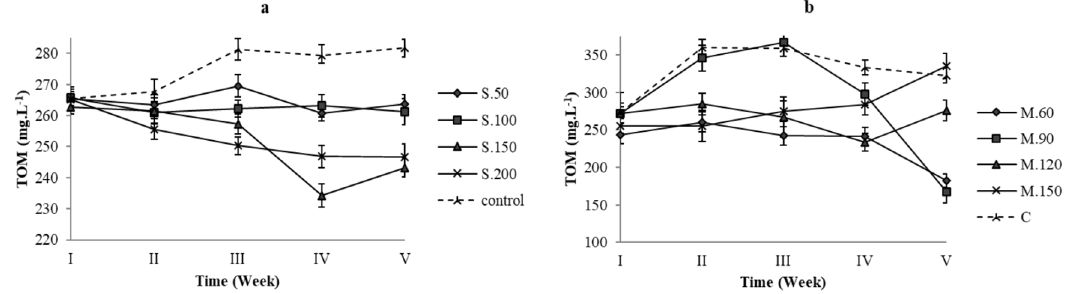
Fig. 2. Concentration dynamics of TOM (mgL (cid:1) 1 ) in the control and at four densities of G. verucosa (a) and P. viridis (b).